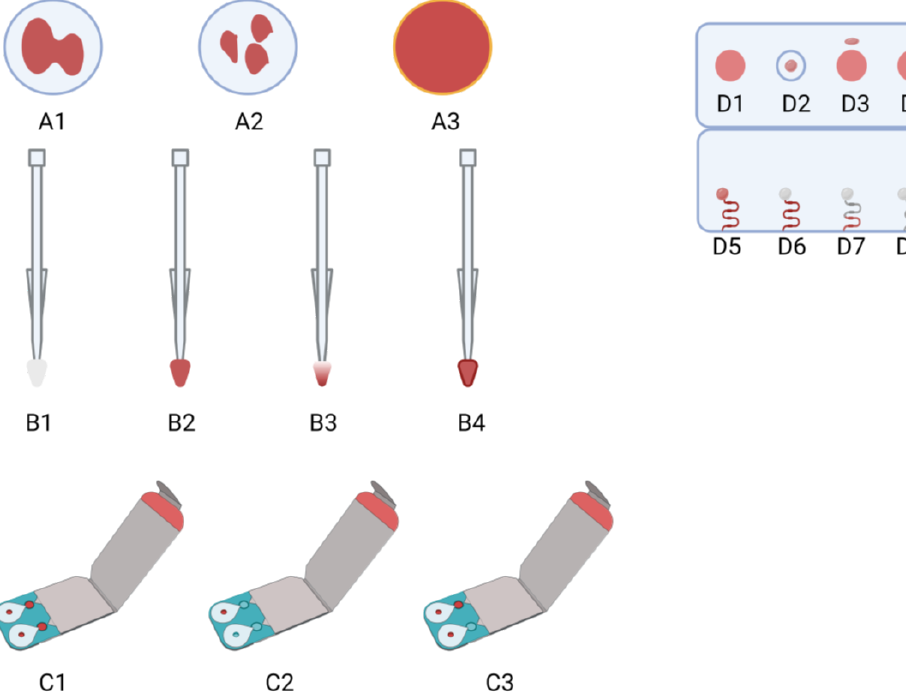
Figure 3. Comparison of typical problems during sampling for selected microsampling methods: (A) DBS, (B) VAMS—Mitra™, (C) qDBS—Capitainer™, and (D) Hemaxis™. Issues description: ( A1 ) layering; ( A2 ) multiple blood applications; ( A3 ) chromatographic effect (serum ring); ( B1 ) blank VAMS sampler; ( B2 ) correctly loaded VAMS sampler; ( B3 ) unloaded VAMS sampled; ( B4 ) overloaded VAMS sampler; ( C1 ) correctly sampled qDBS; ( C2 ) unloaded qDBS; ( C3 ) correctly loaded and unloaded sampler windows (left and right, respectively); ( D1 , D3 , D5 ) sample correctly loaded and punched; ( D2 , D4 , D6 , D7 ) unloaded blood sample and/or potential punch mistakes; ( D8 ) an open capillary system for comparison purposes. Created with BioRender.com under publishing